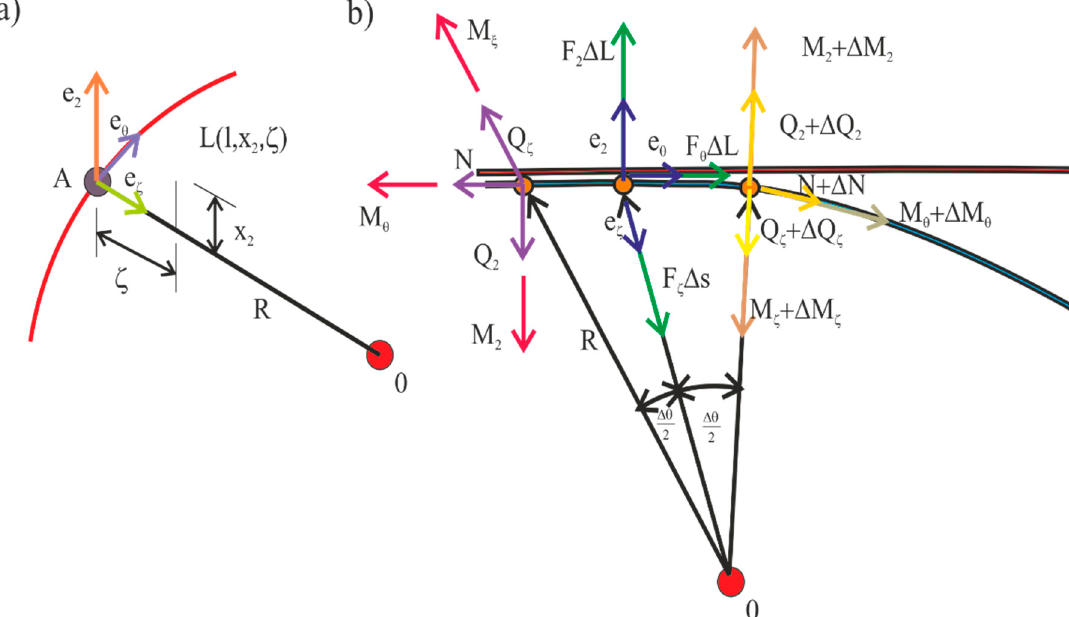
Figure 6. Coordinate system defining the switch point ( a ) and model of the switch point ( b ).